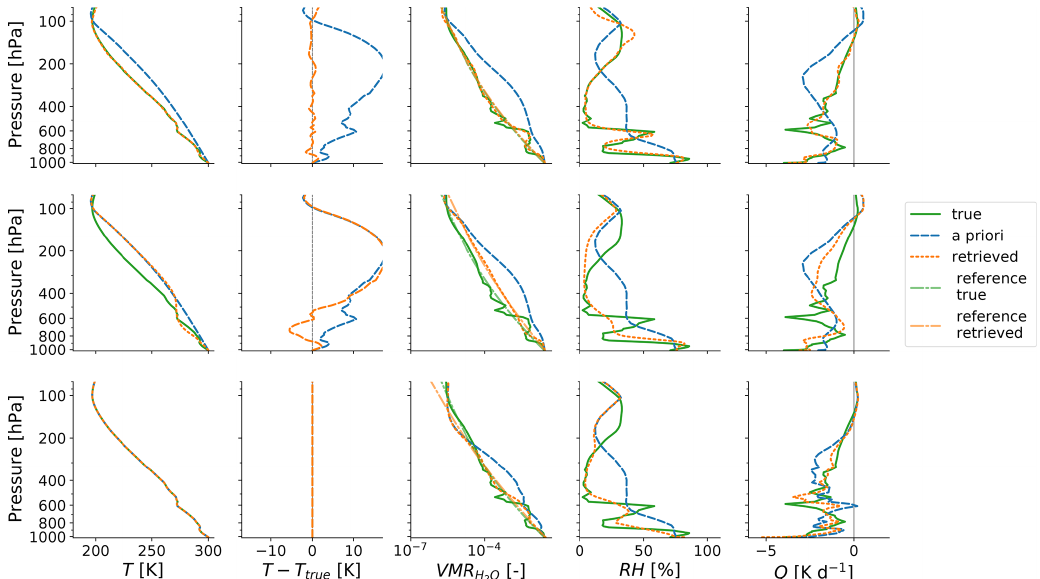
Figure 4. Columns show profiles of temperature ( T ), temperature differences of a priori and retrieved states to the true state, VMR H relative humidity (RH) and net heating rates ( Q ) for the dropsonde profiles that sampled the EML discussed by Stevens et al. (2017) (labelled as “true” here). Displayed are the true states that are used as a basis for the forward-modelled synthetic IASI observation, the a priori states of the retrieval and the retrieved states. The VMR H reference profiles defined in Sect. 3 are also depicted. Rows show retrieval results based 2 O on different retrieval setups that are introduced in the